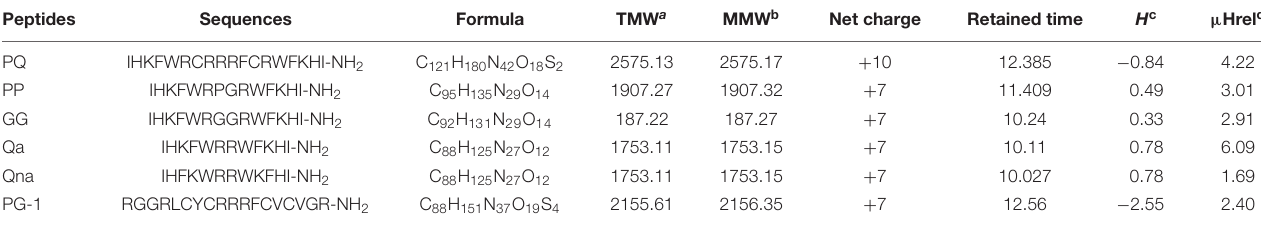
TABLE 1 | Peptide design and key physicochemical